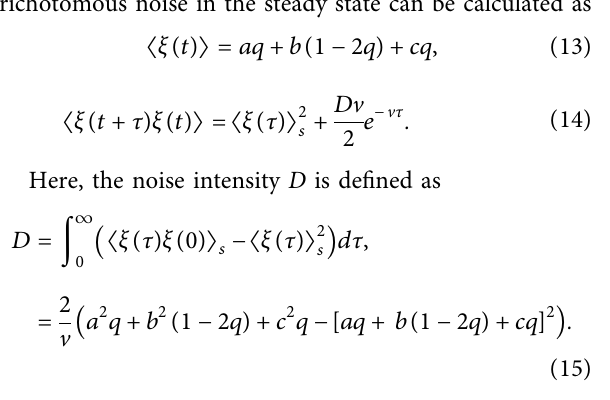
( x ) for different values of α . (c) Potential U 2